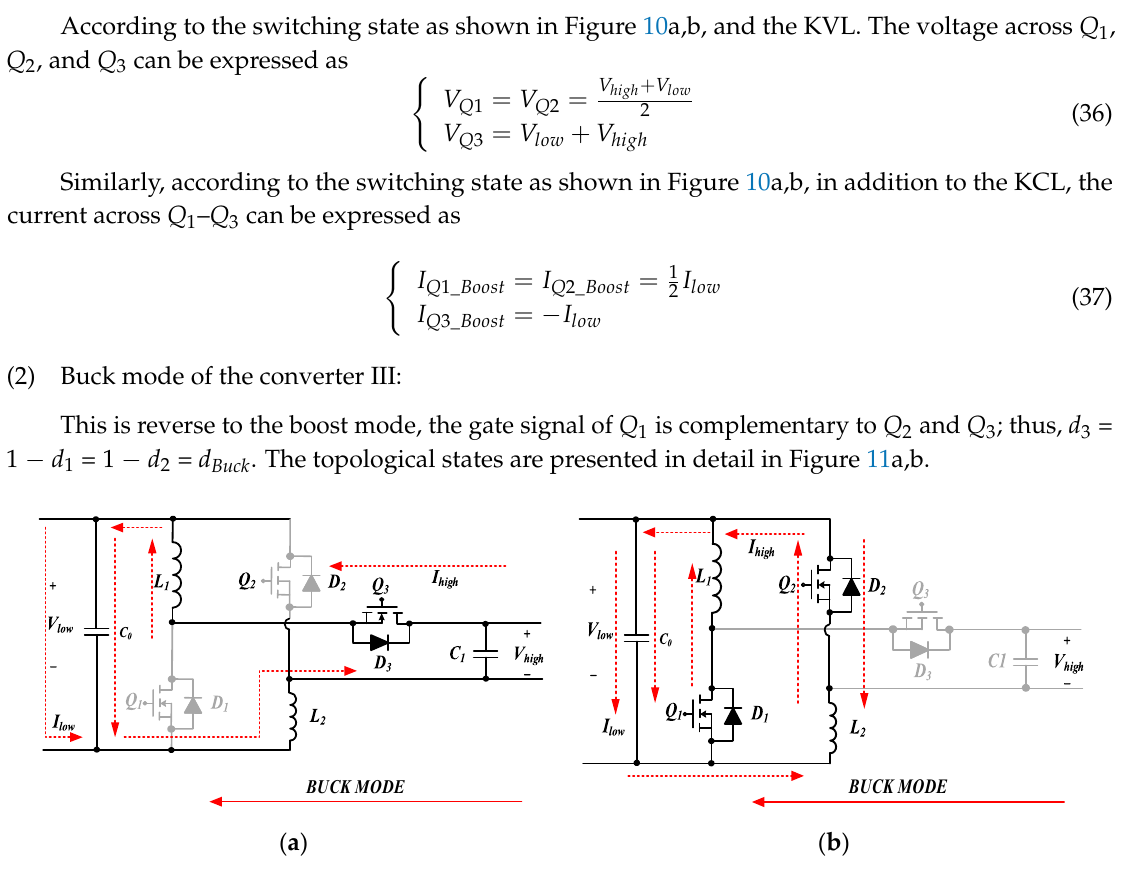
Figure 11. Topological states of Converter III in the buck mode. ( a ) [ t 0 – t 1 ]. ( b ) [ t 1 – t 2 ]. [ t 0 – t 1 ]. When switch Q 3 is ON, and Switches Q 1 and Q 2 are OFF, the switching state is presented